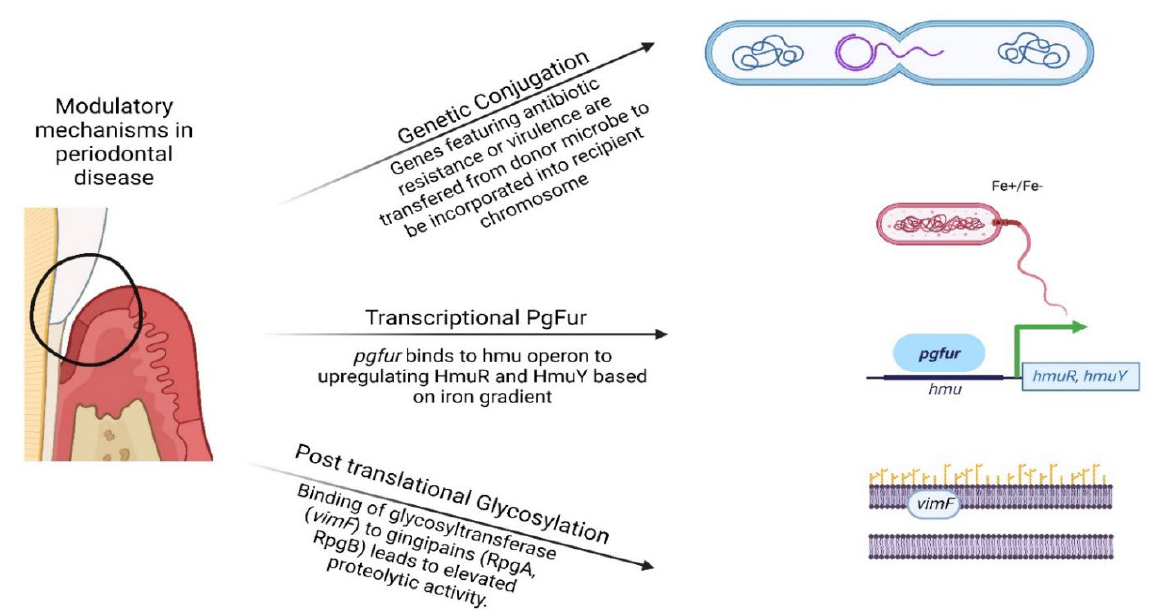
Figure 1. Visual representation of the genetic, transcriptional, and post-translational modifications of periodontal pathobionts presented in this review. (Created by BioRender.com) accessed on 20 October 2022.